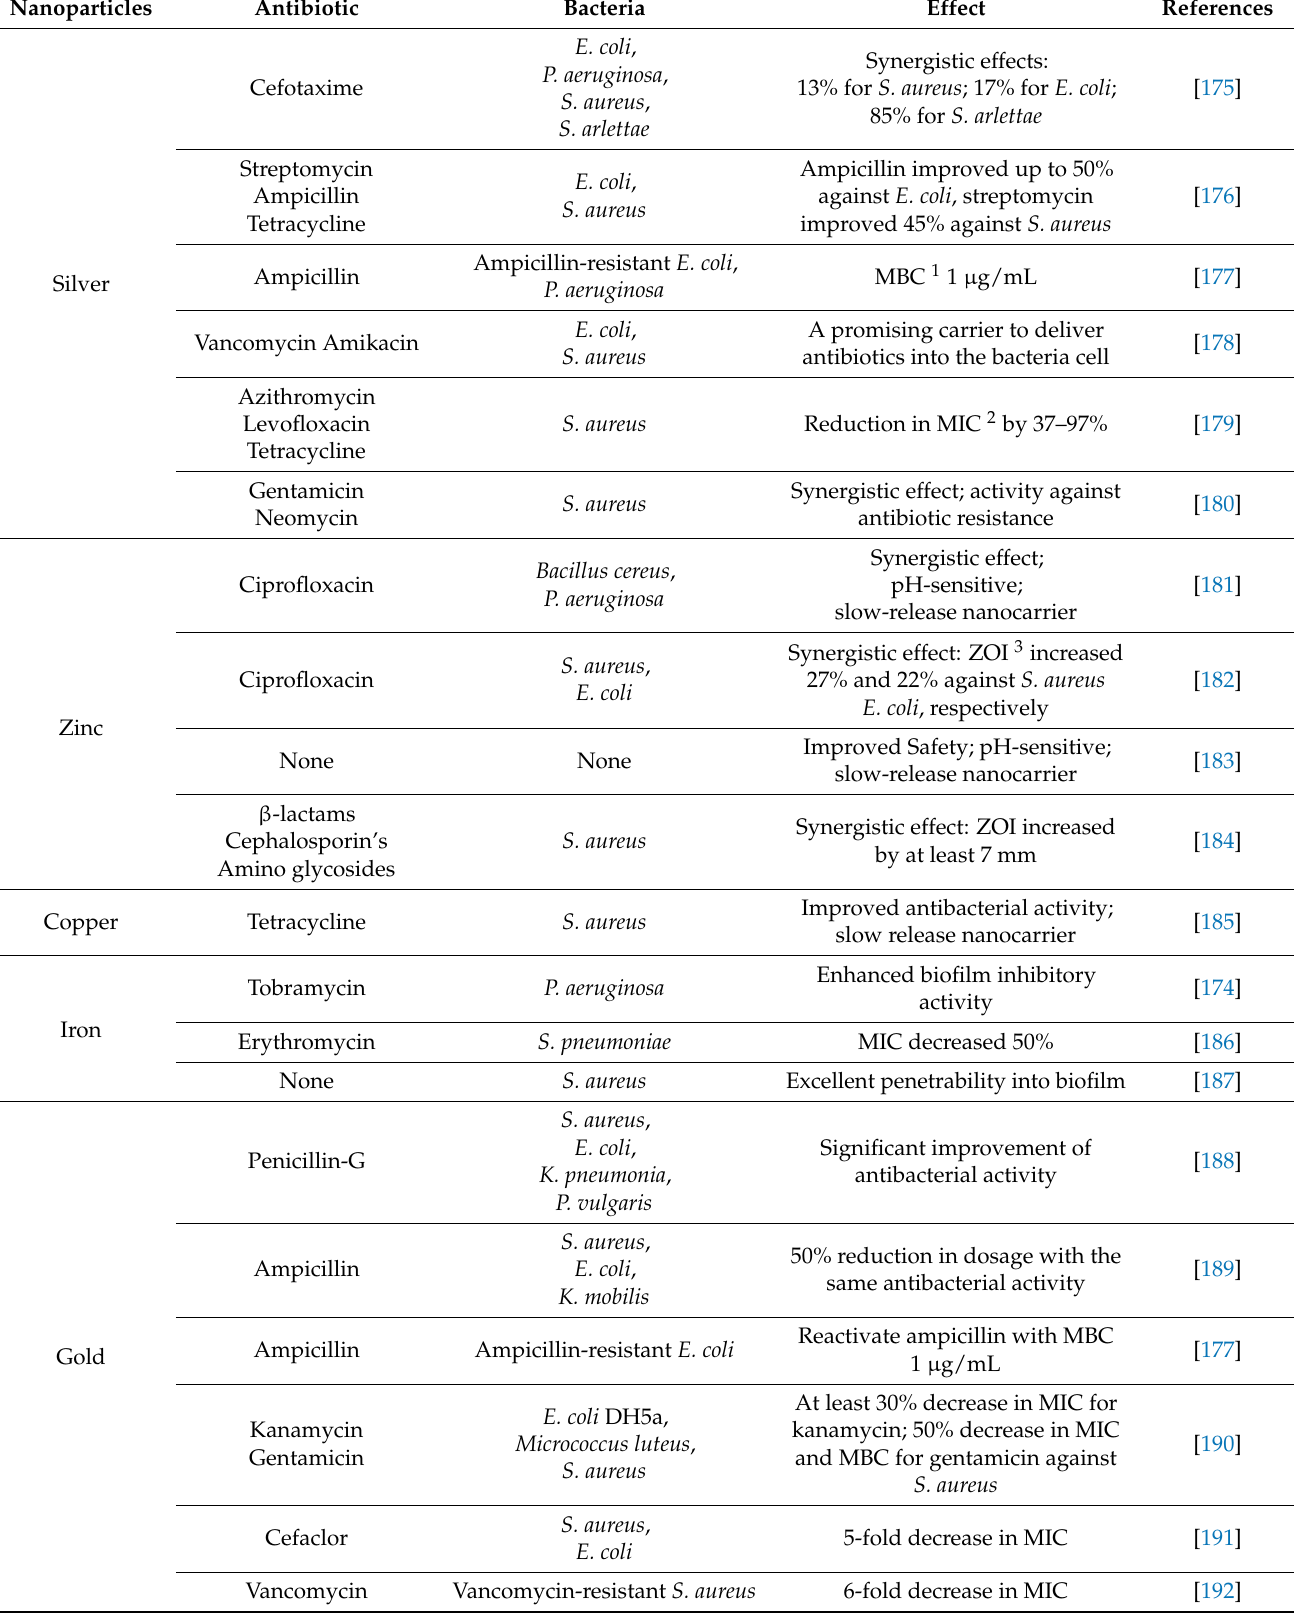
Table 1. Antibacterial potency of metal nanoparticles complexed with